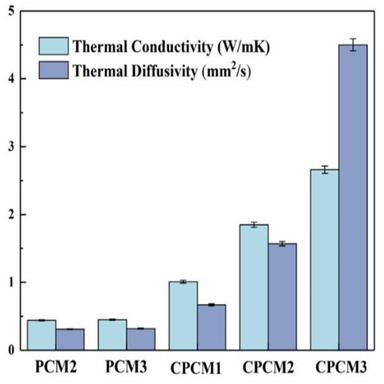
Thermal conductivity and thermal diffusivity of the PCM2-PCM3 and CPCM1–CPCM3.